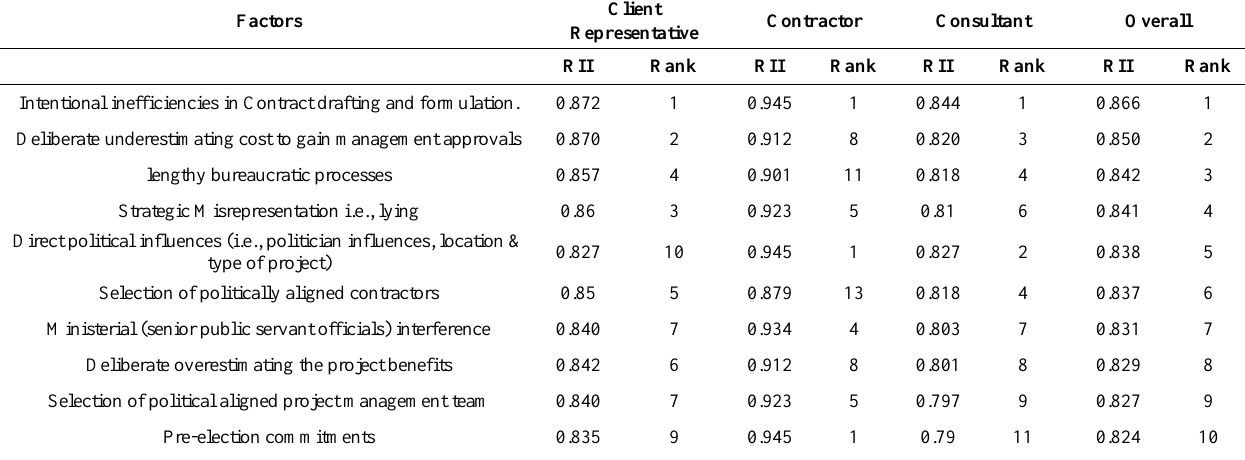
Table 6. Severity of cost overruns